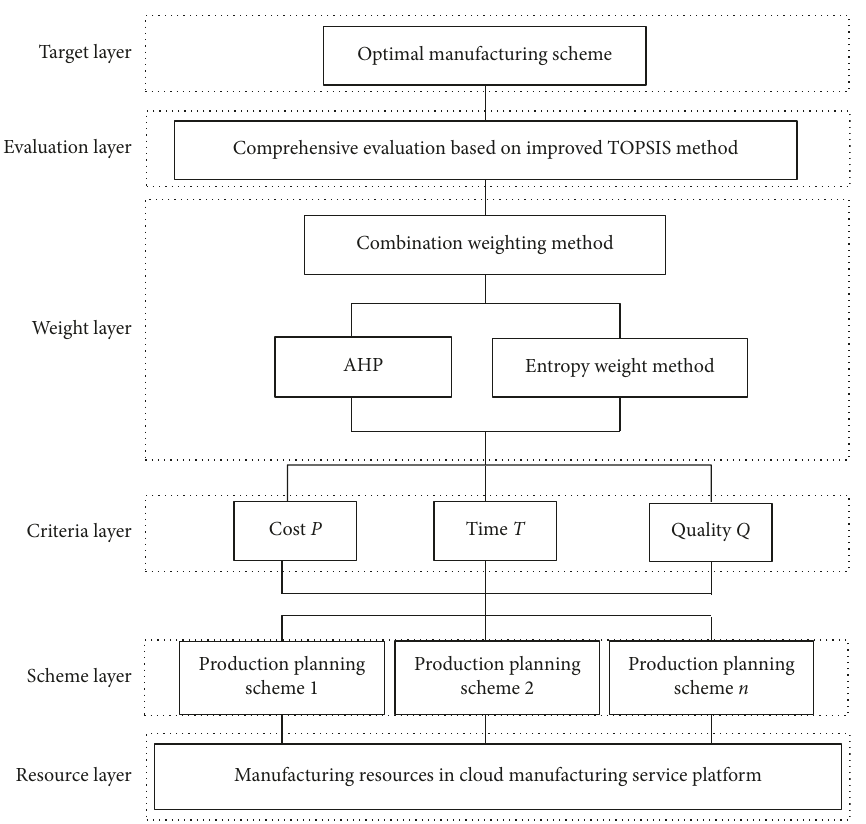
Figure 2: A model for evaluating and optimizing production schemes in cloud manufacturing environment. Table 1: Six common attribute